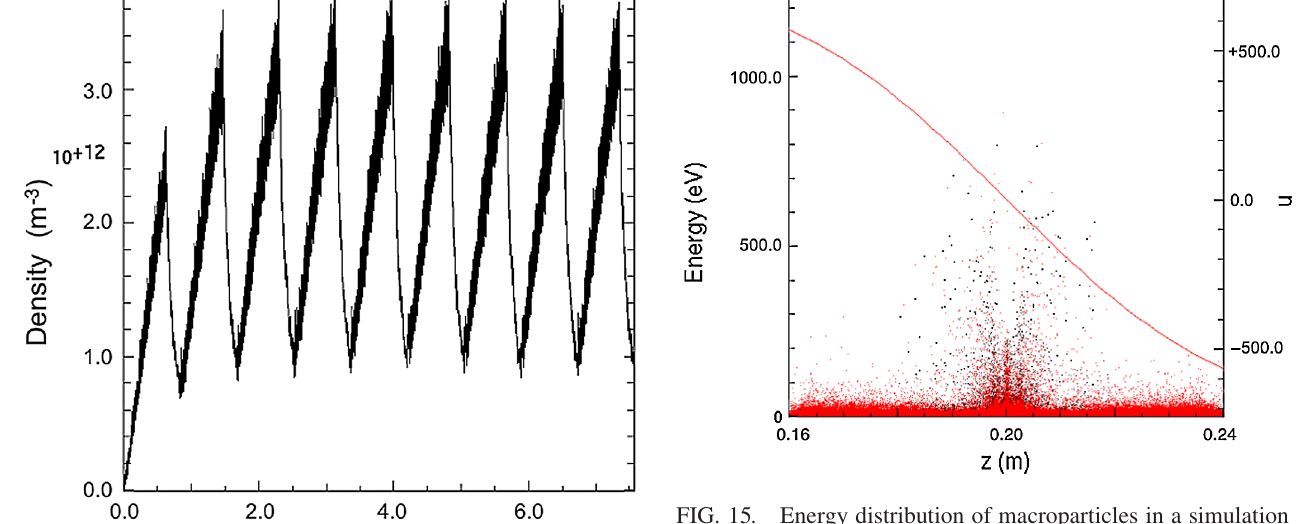
FIG. 15. Energy distribution of macroparticles in a simulation of an 8 cm range in z centered at a field null, which occurs at z ¼ 0 : 2 m . Dots are macroparticles. Red dots are secondary macroelectrons; black are primary macroelectrons. The graph is recorded just before the 45th bunch appears, at 616 ns. The curve superimposed is n vs z at y ¼ 0 , where n is the ratio of the cyclotron frequency to the bunch